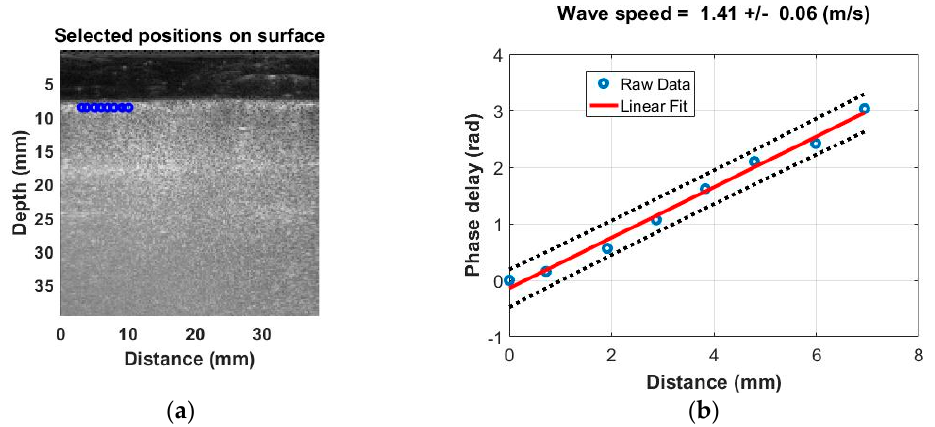
Figure 2. ( a ) An example of a B-mode image of the right lung of the swine. The lung motion was measured at eight locations on the surface of the lung. ( b ) An example analysis of the surface wave speed at 100 Hz. The lung surface wave speed was analyzed using the wave phase delay relative to the first location.